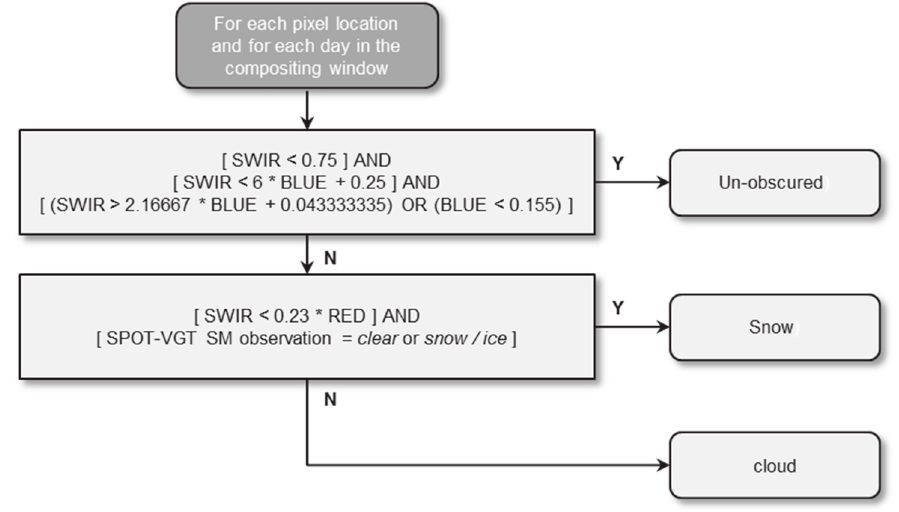
Figure 4. The MC10 algorithm assigns an observation class to each pixel location each and every day that is